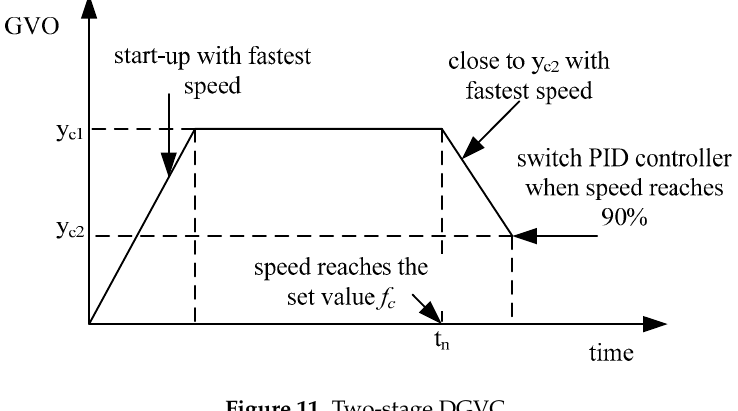
Figure 11. Two-stage DGVC.